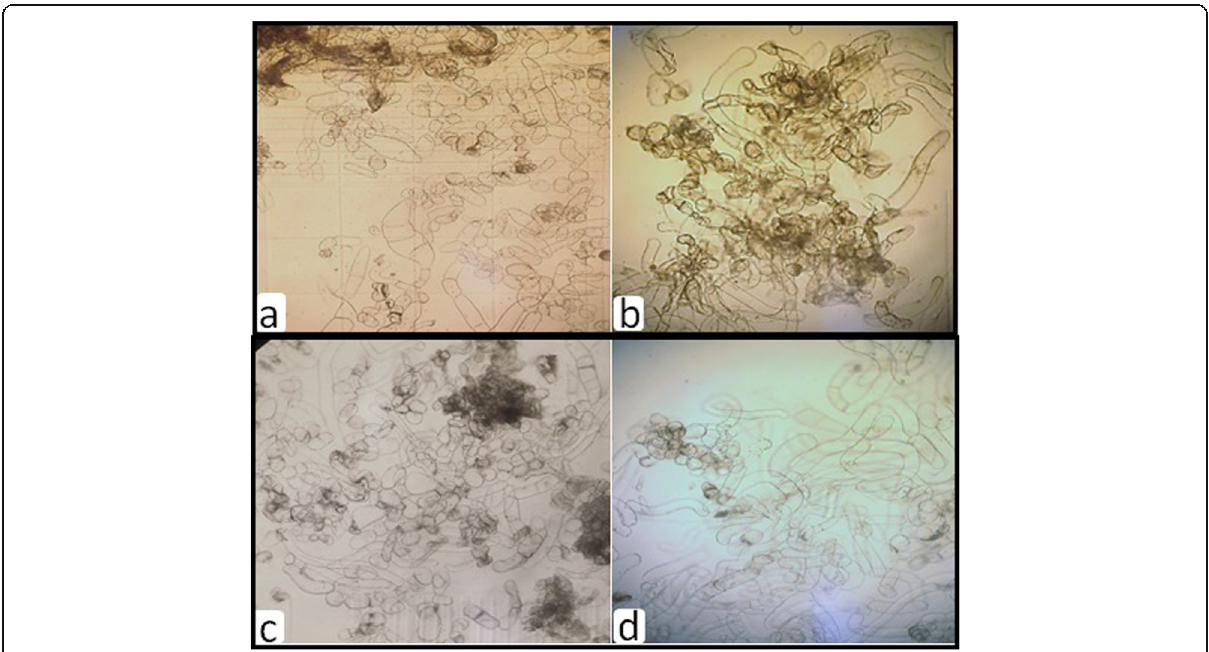
Fig. 2 Morphological characterization of globe artichoke cells after cryopreservation treatments. a 20, b 40, c 60, d 80 min exposure time to PVS2 using light